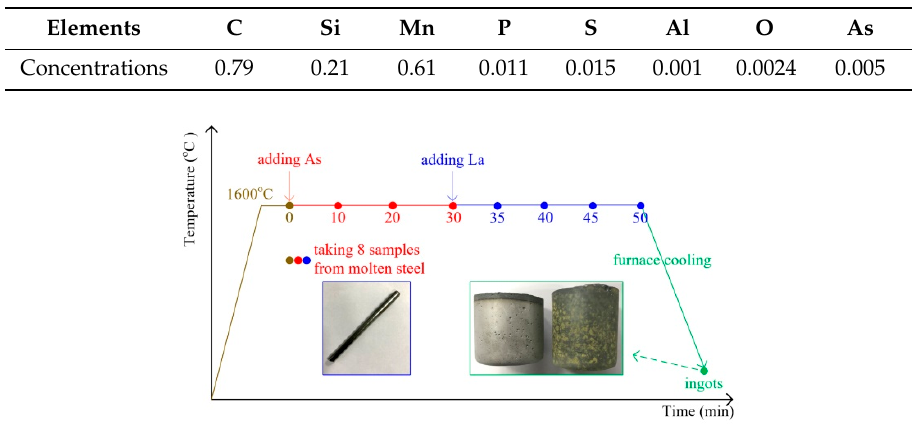
Figure 1. Details of the sample preparation process.